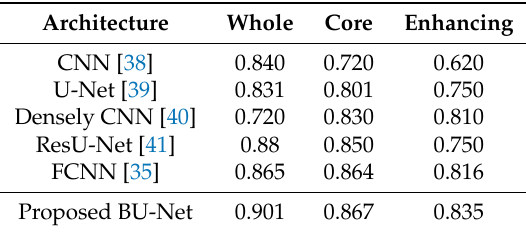
Table 2. Comparison of results with the BraTS 2017 HGG data.